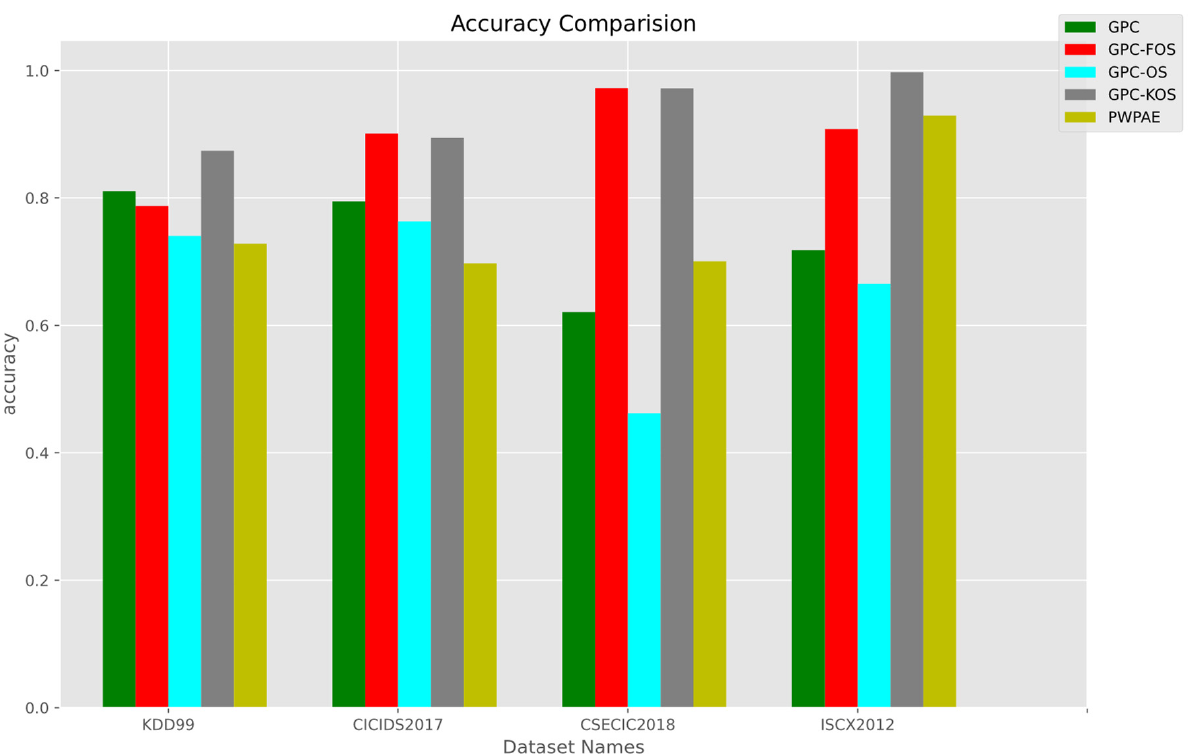
Figure 13. Accuracy of the incremental GPC (OS, FOS, KOS) variants and benchmarks (GPC, PWPAE) for real-world data.